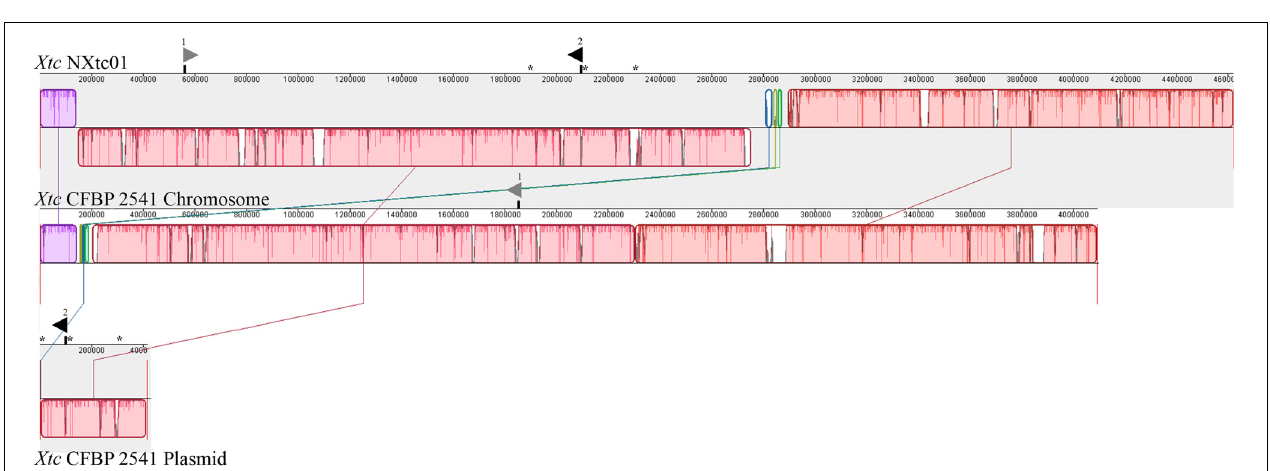
FIGURE 3 | Organization of the whole genome and tal genes of Xtc strains NXtc01 and CFBP 2541. Genomes starting from gyrB gene were aligned using progressive MAUVE with default parameters (http://darlinglab.org/mauve). Horizontal axes show sequence coordinates in base pairs. The colored, locally collinear blocks (LCB) shows conserved and highly similar genomic regions; white areas inside colored regions indicates sequence elements specific to one genome that were not aligned. Height of similarity profile is present inside each block. The colored lines that connect LCBs represent translocations of homologous regions. Blocks above or below the horizontal bar indicate regions that aligned in the forward or reverse orientation, respectively (same-colored LCBs on opposite side of the center line indicates an inversion). Asterisks indicates IS elements that bordered tal2 . The two tal genes are represented as triangles above the sequence coordinates, pointing toward transcriptional orientation on chromosomal or plasmid DNA. Black filled triangles indicate tal 2 on chromosome in NXtc01 and on plasmid in CFBP 2541, encode identical RVDs. Gray filled triangles indicate tal1 (see Table 2 for RVD